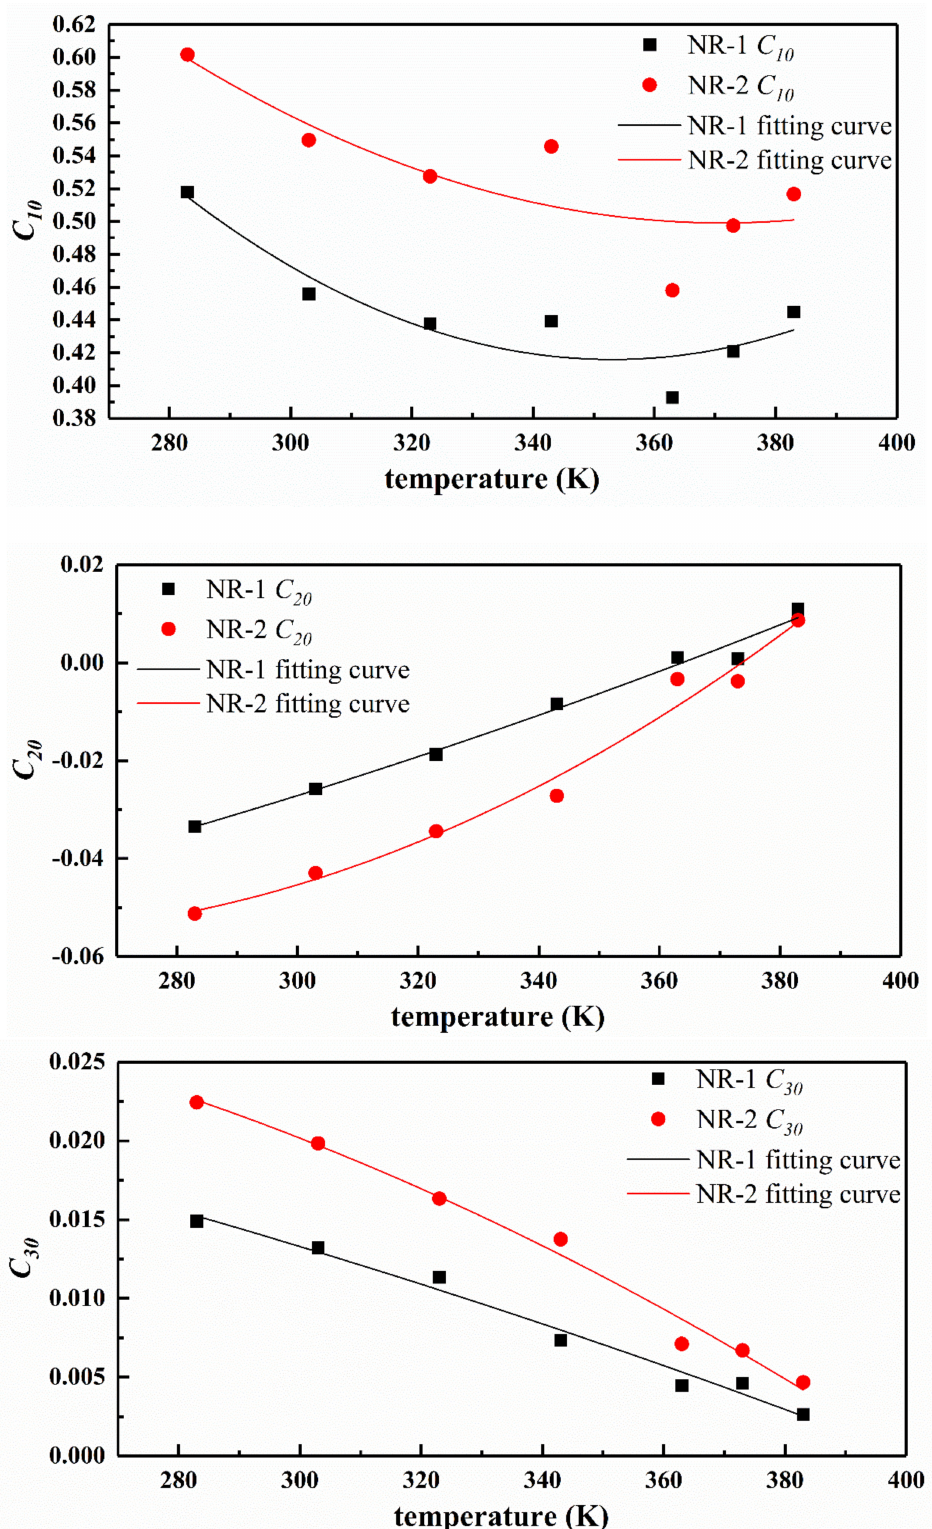
Figure 9. Trend of Yeoh model parameters with temperature and the corresponding quadratic fitting